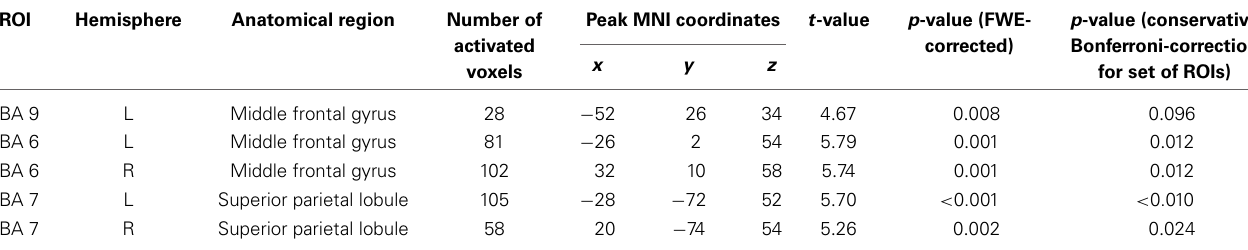
Table 2 | Cerebral activation associated with increasing task load during CBT retrieval across all participants. ROI Hemisphere Anatomical region Number of voxels